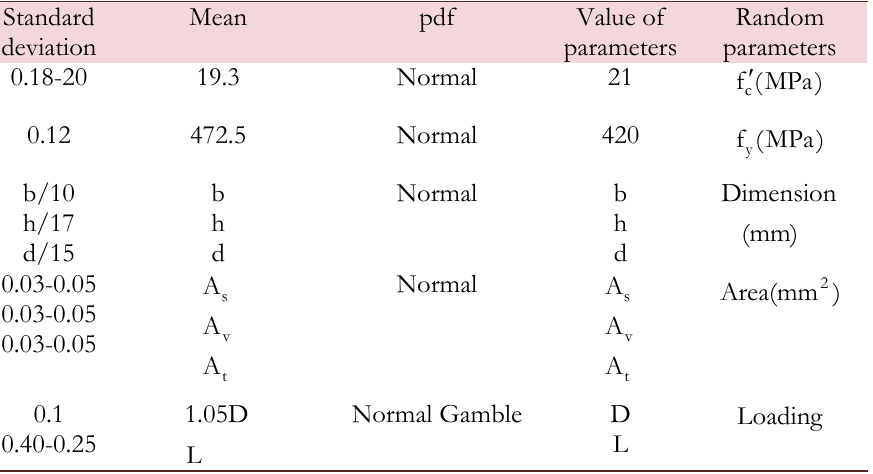
Table1: Statistical values of the used parameters for design the sections of reinforced concrete [17-20]. Limit function and safety index